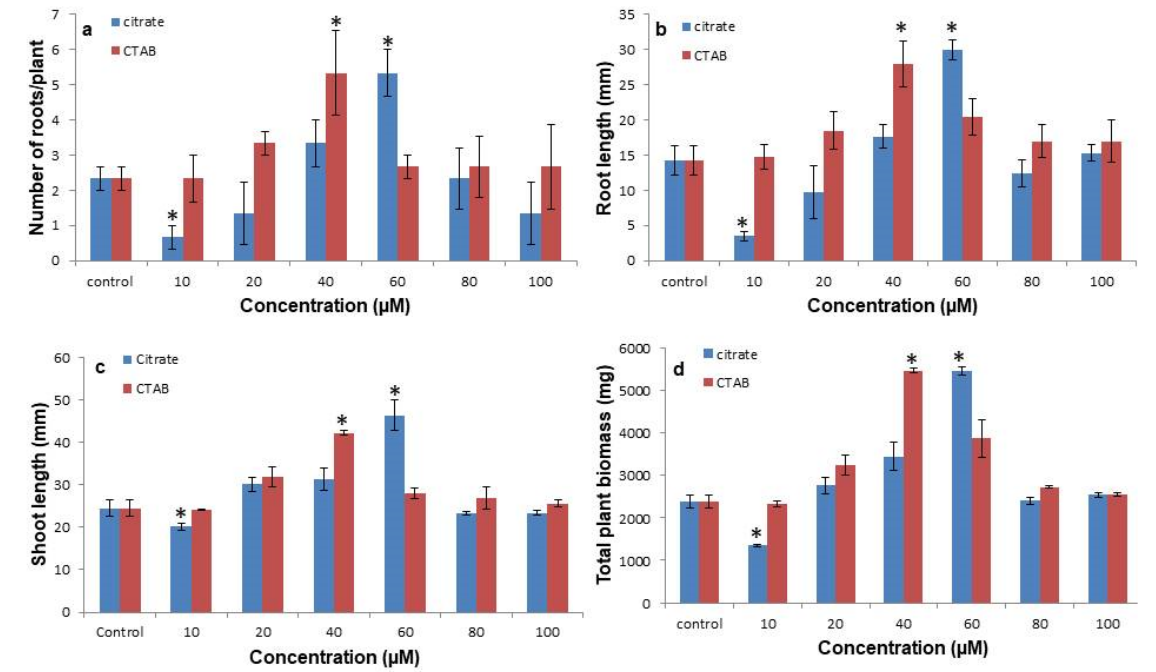
Figure 3. The effect of citrate-AuNPs and CTAB-AuNPs on the in vitro growth of N. jatamansi . ( a ) Effect on the number of roots per plant; ( b ) effect on root length ( c ) effect on shoot length; ( d ) effect on the total plant biomass. Error bar represents the standard error of three biological replicates. * Indicates significantly reduced and enhanced concentrations in comparison to the control.